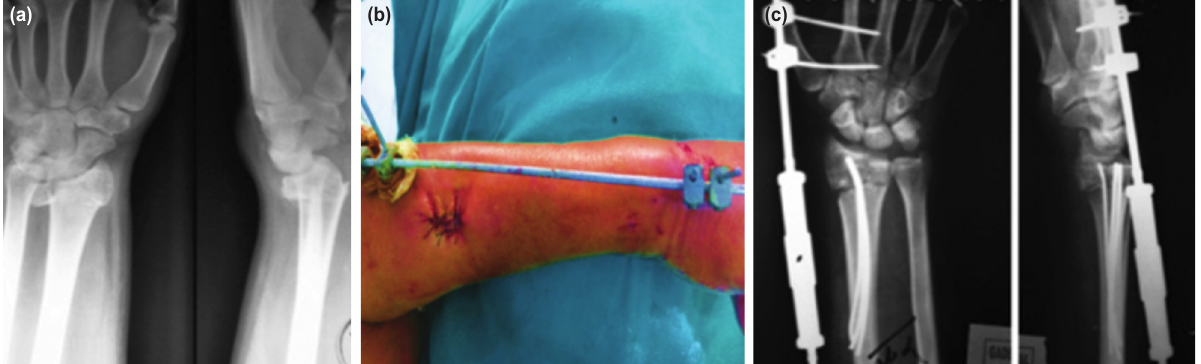
(a) AP and lateral radiographic images showing of a case with osteoporosis and comminuted distal radial fracture, (b) clinical Fig. 3: photograph showing placement of an external fixator, (c) Radiographic views following final placement of IM wires and external fixator.